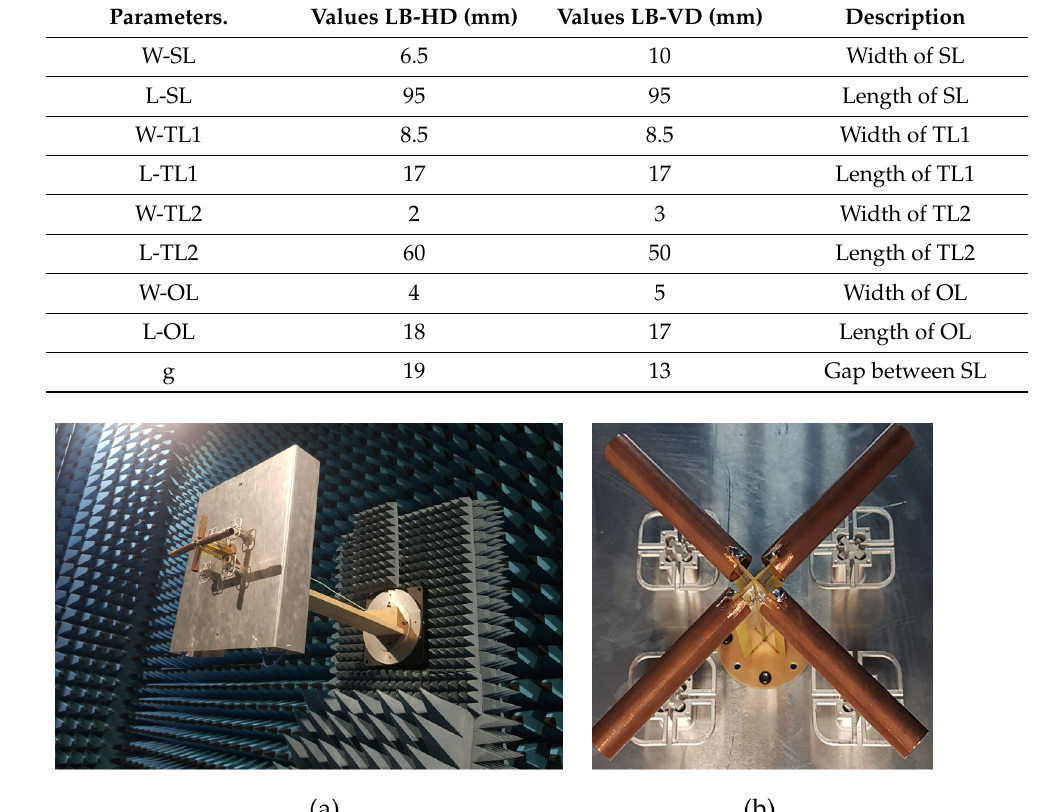
Table 3. Optimized parameters of the proposed antenna. Parameters.